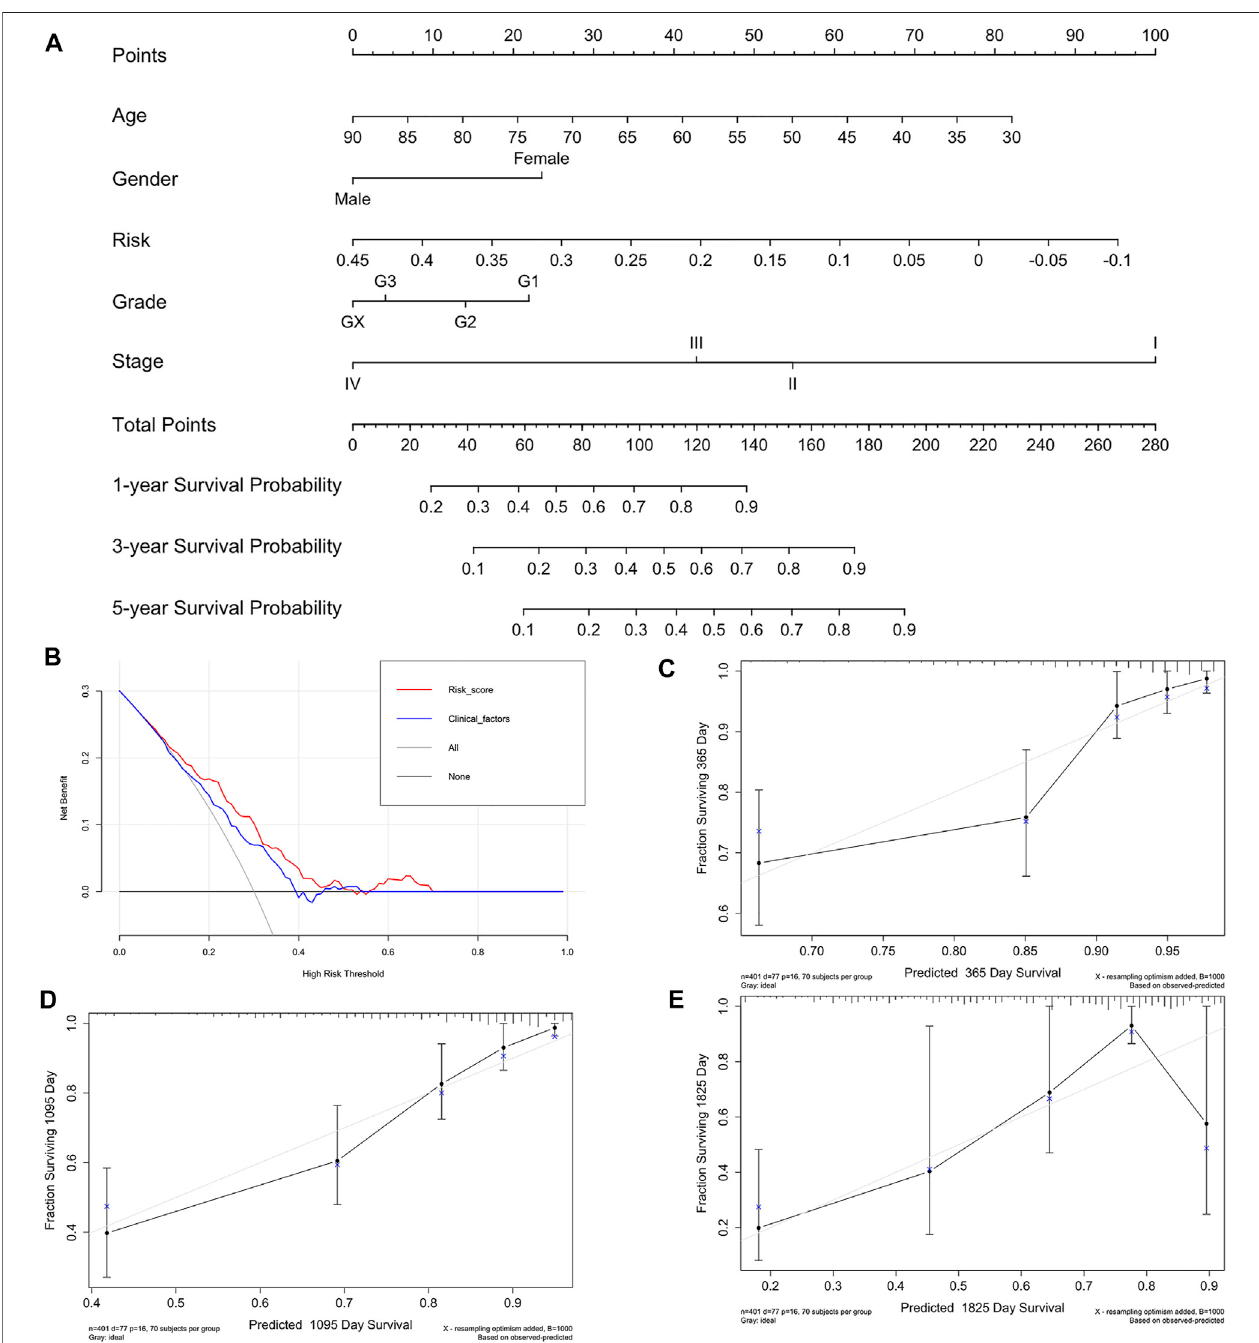
FIGURE 9 | Nomogram of IRS and its stability evaluation. (A) Nomogram for predicting survival probability of GC patients in the training group. The total score of clinicopathological features as well as risk score for each sample is located on the “ total points ” axis, which corresponds to the survival probabilities on the 1-, 3-, and 5-year axes. (B) Decision curve for nomogram and clinical factors. (C – E) Calibration curves for nomogram in 1-, 3-, and 5-year, respectively.